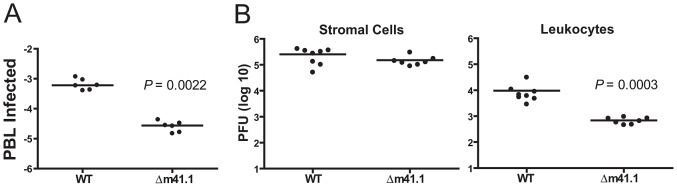
m41.1 enhances viral replication in leukocytes.(A) Whole blood was isolated from infected mice on day 5 pi., and red blood cells removed by isotonic lysis. The proportion of infected cells was determined by infectious centre assay. (B) Mice were infected with WT MCMV or the Δm41.1 mutant and spleens removed on day 4 pi. Viral burden in stromal cells (left panel), or leukocytes (right panel) were determined by plaque assay.